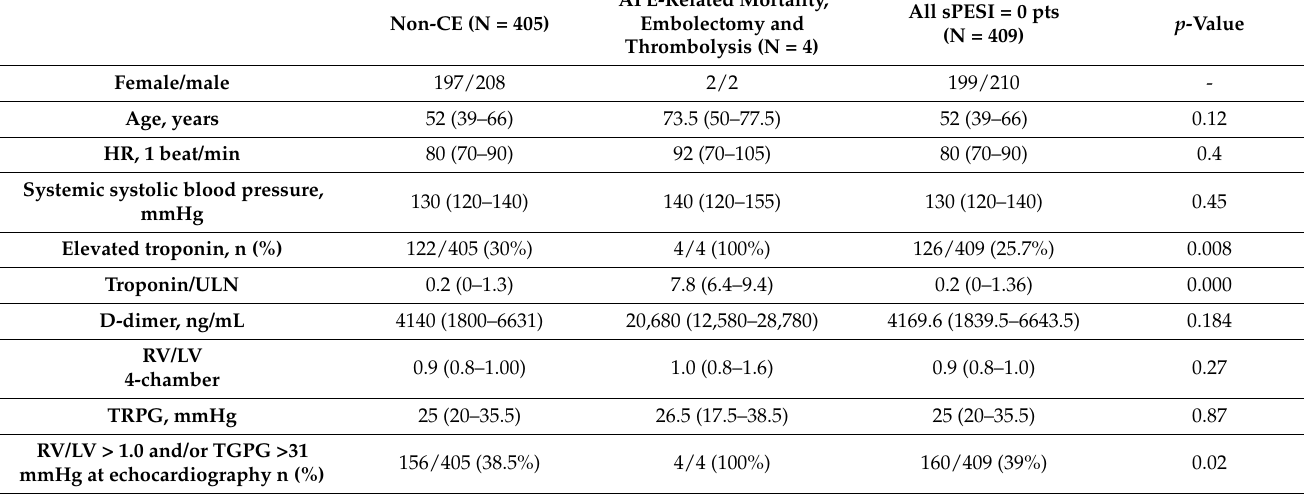
Table 1. Clinical characteristics of APE patients. Data are presented as median followed by